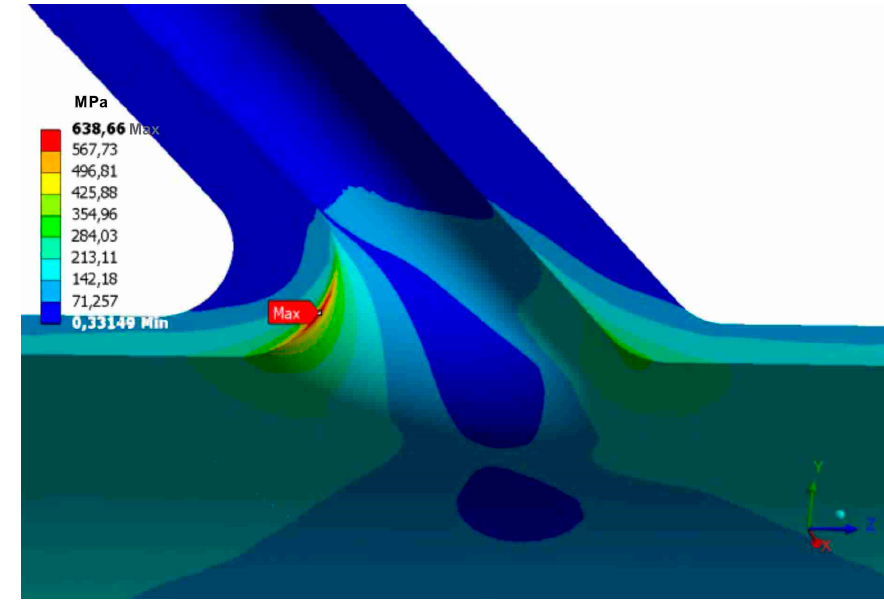
Figure 26. Stress distribution (von Mises) in the nozzle intersection area at 133.1 bar internal pressure.